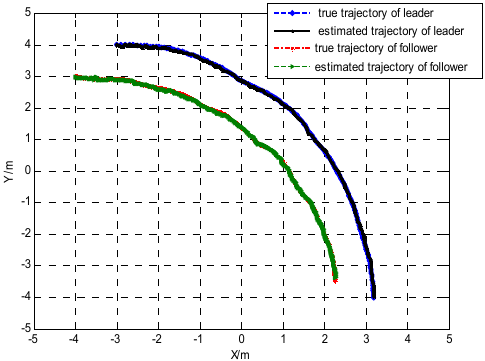
Figure 3. The true trajectory and the estimated trajectory for the leader–follower robot team.